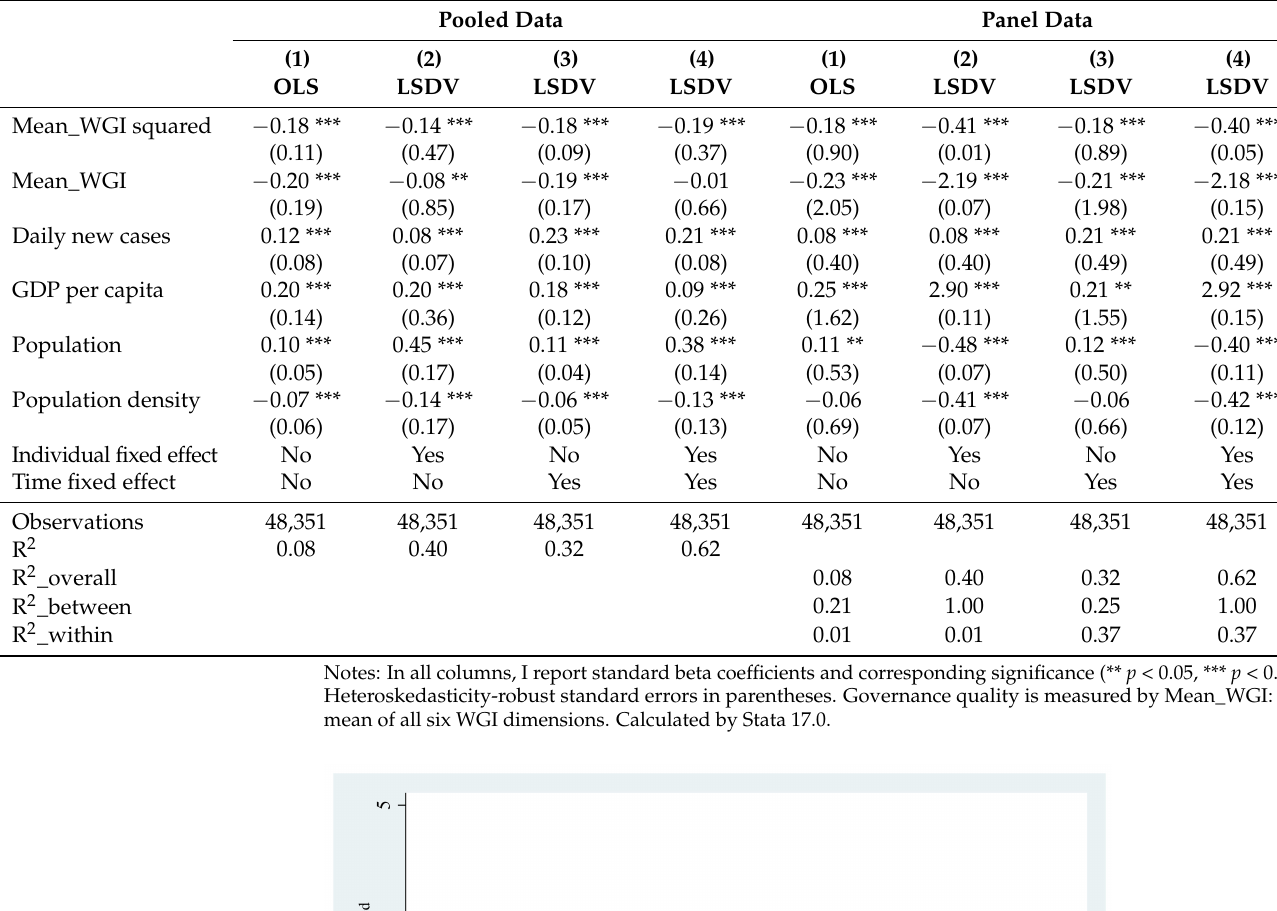
Table 4. Regression results of the main model.